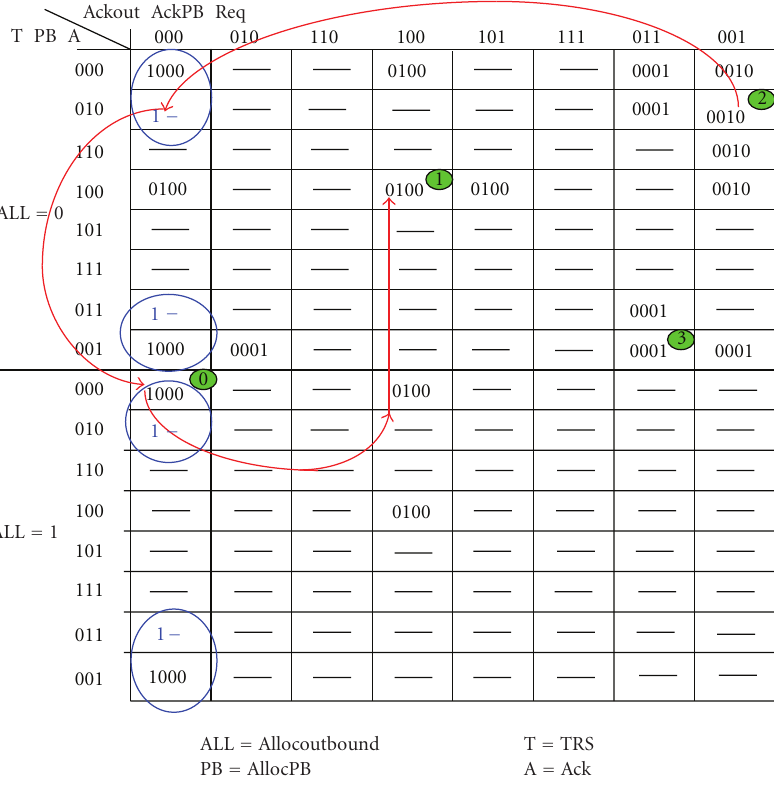
Figure 15: BM flow map showing a transient essential